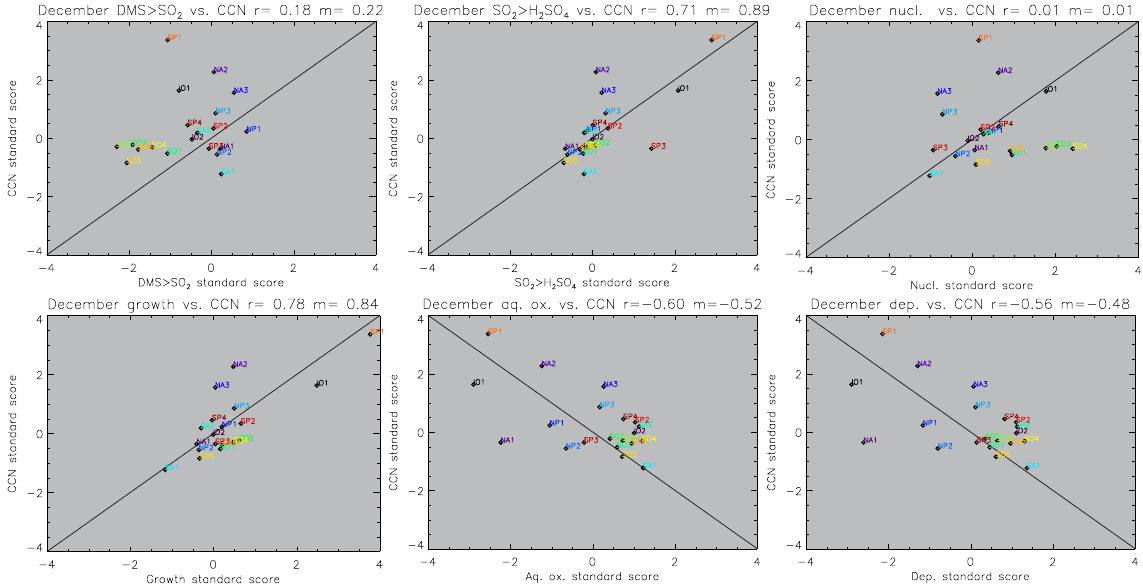
Fig. 7. December standard scores for CCN sensitivities plotted against the process sensitivities for each patch. Also shown are the 1:1 line (or negative 1:1 line), r and m values of the linear best fit. The patch names are shown next to their respective datapoints. Colours are used to help differentiate the datapoints from one